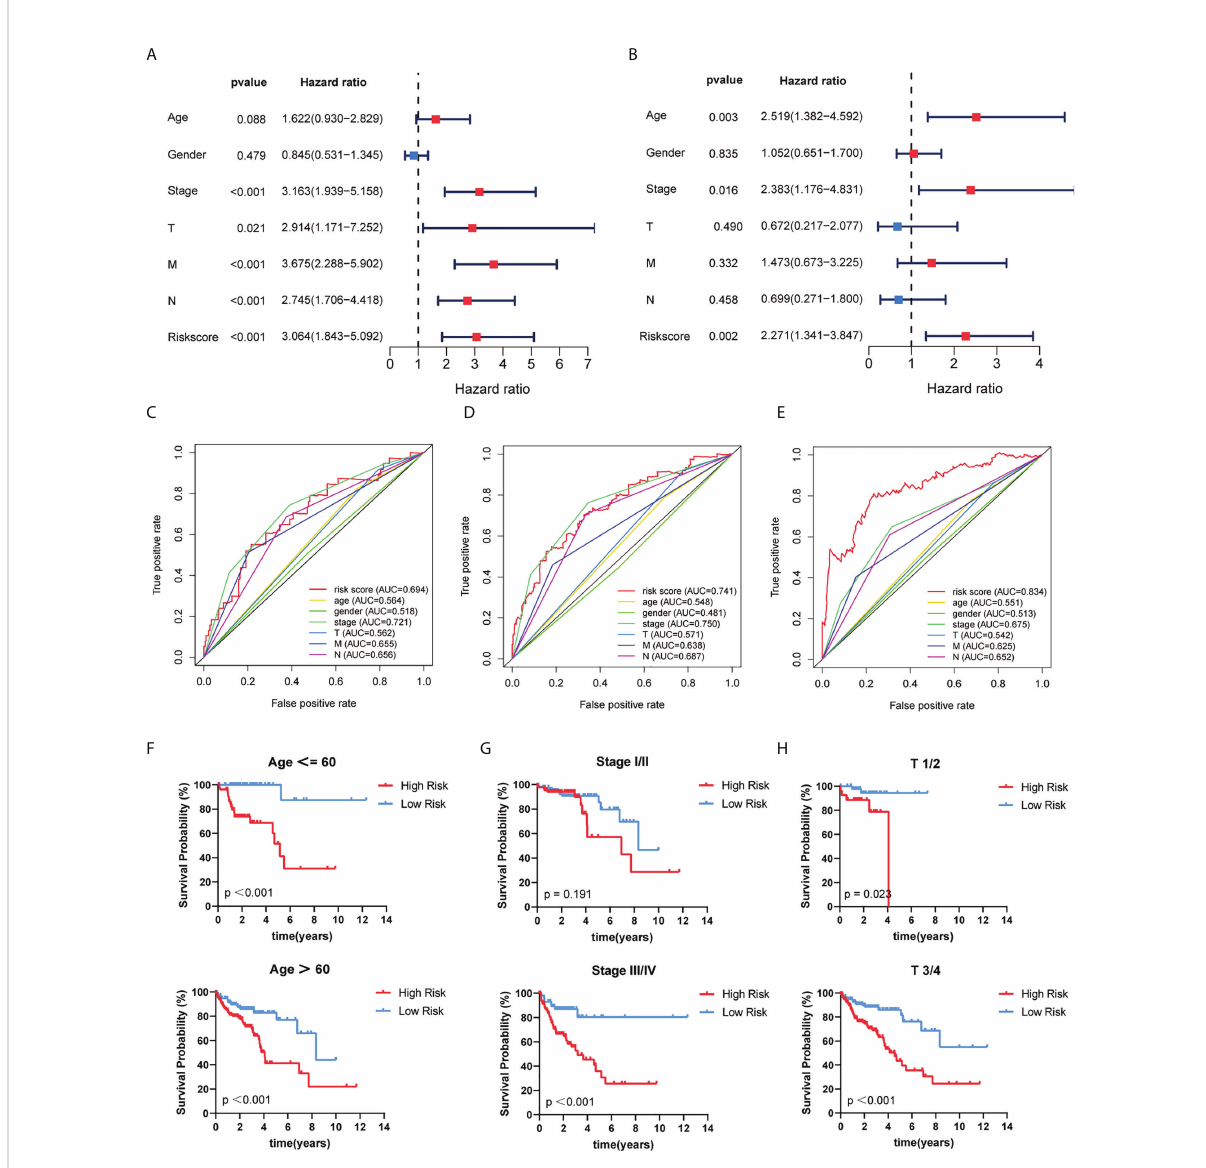
FIGURE 5 Independent prognostic role of risk model signature. (A, B) Univariate and multivariate Cox regression analyses of risk scores and clinical characteristics. (C – E) Determination of the area under the ROC curve (AUC) of the risk score and clinical features based on the ROC curve. (F – H) The Kaplan – Meier curve shows the prognostic value of the risk model for COAD patients categorized by age, stage, and T